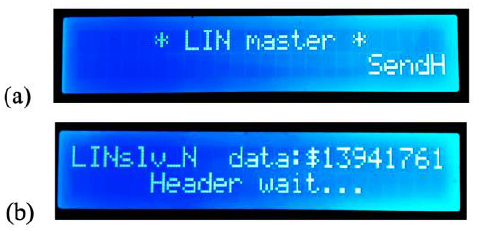
Figure 14. Normal slave node’s screen status after sending the two interleaved LIN responses.